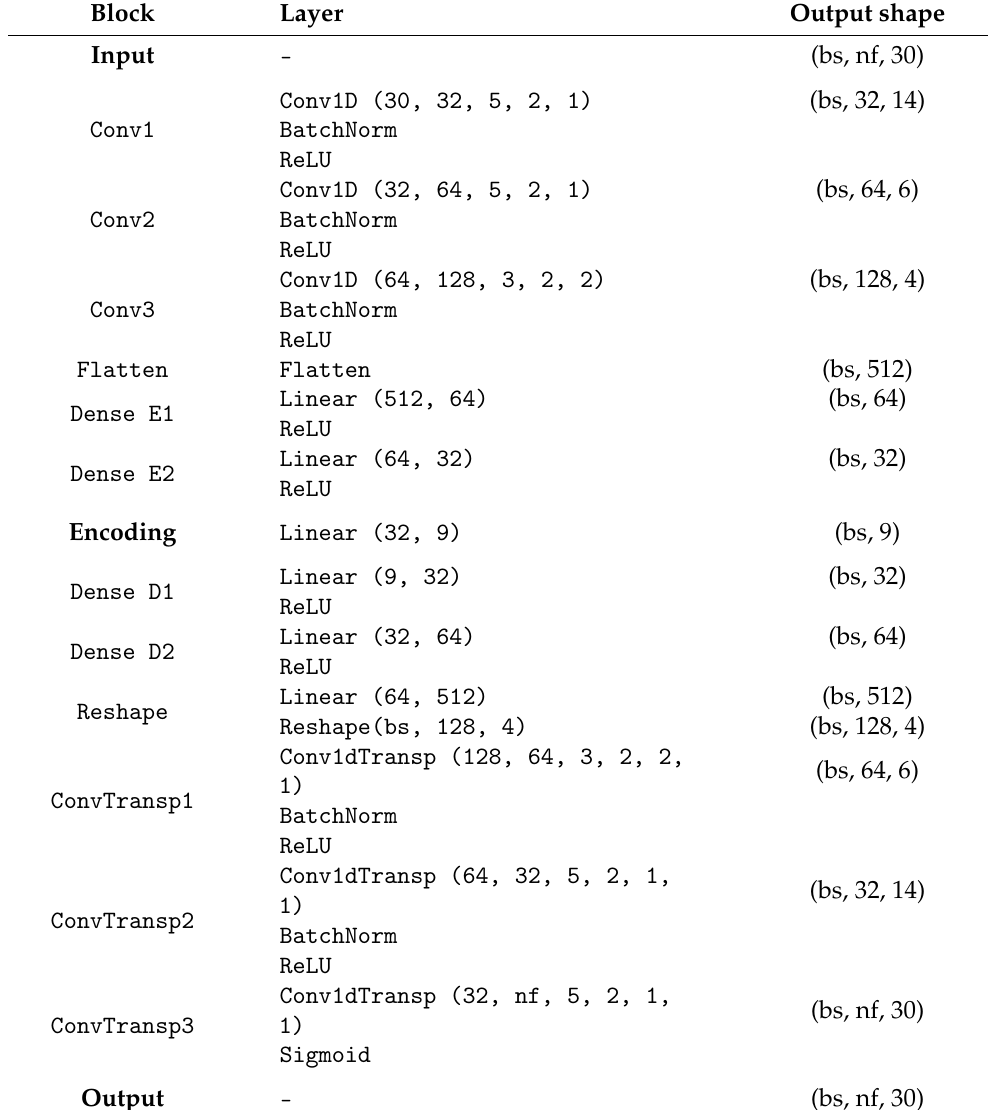
Table 3. Convolutional autoencoder (CAE)